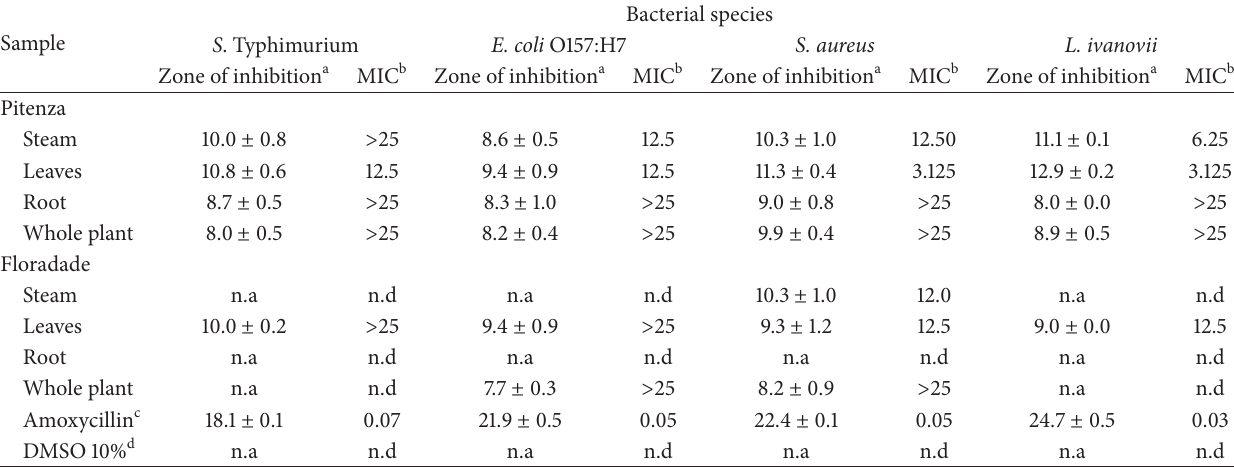
Table 4: Antibacterial activity of tomato plant